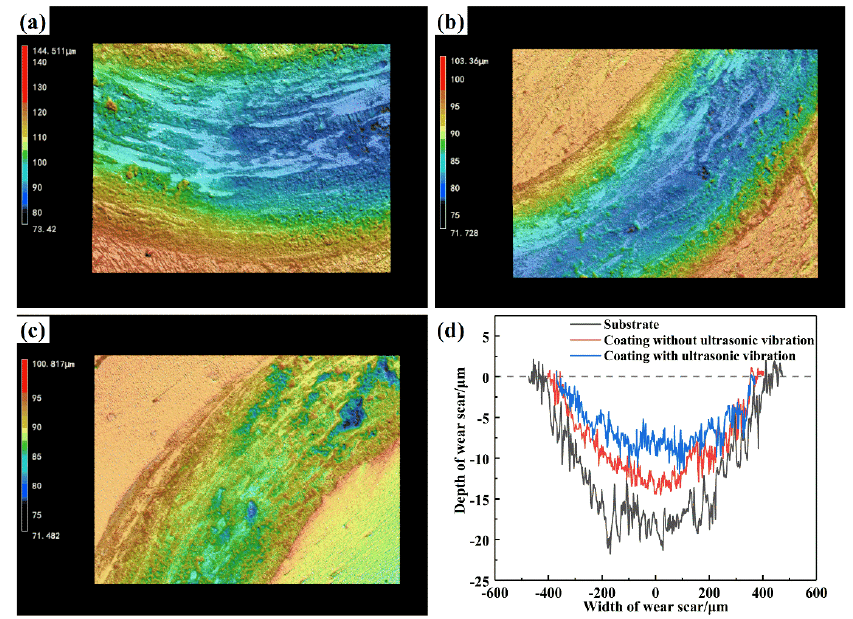
Figure 10. 3D contours of the wear marks: ( a ) substrate, ( b ) coating without ultrasonic vibration, ( c ) coating with ultrasonic vibration, and ( d ) contrast diagram of the wear traces.